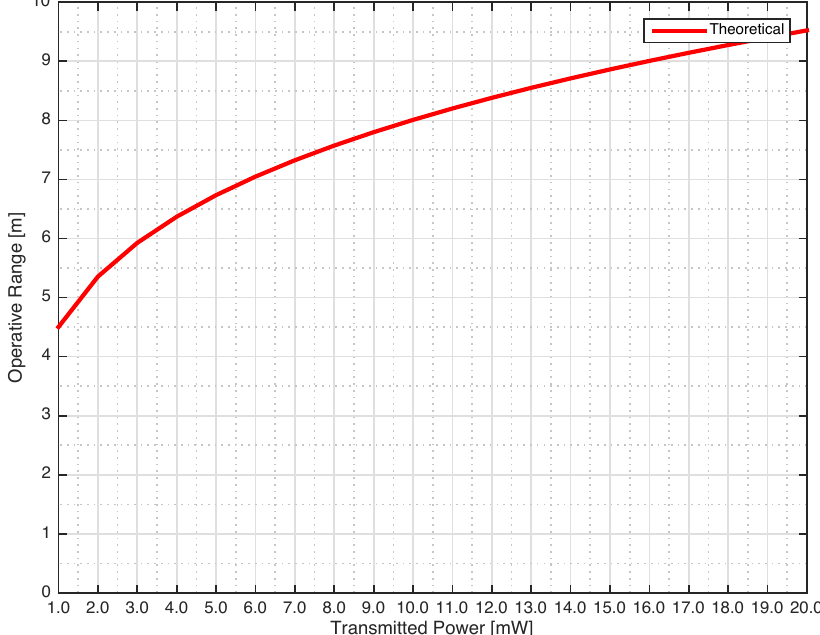
Figure 7. Assessment of the operative range vs. transmitted power in controlled